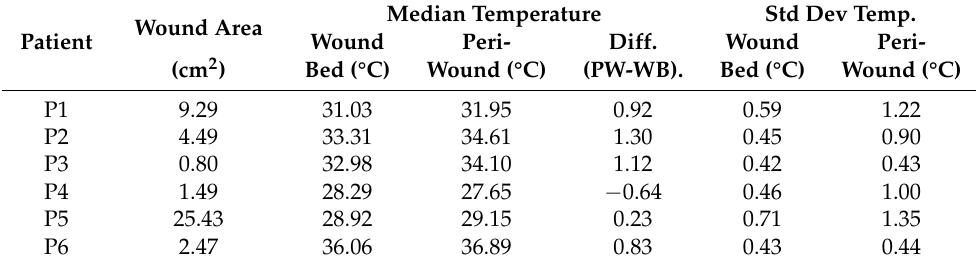
Table 3. Geometrical and thermal indicators obtained with the multimodal and multiview 3D surface thermography. Different patterns are observed especially in the temperature difference between the wound bed (WB) and the periwound (PW) and in the standard deviation of the periwound